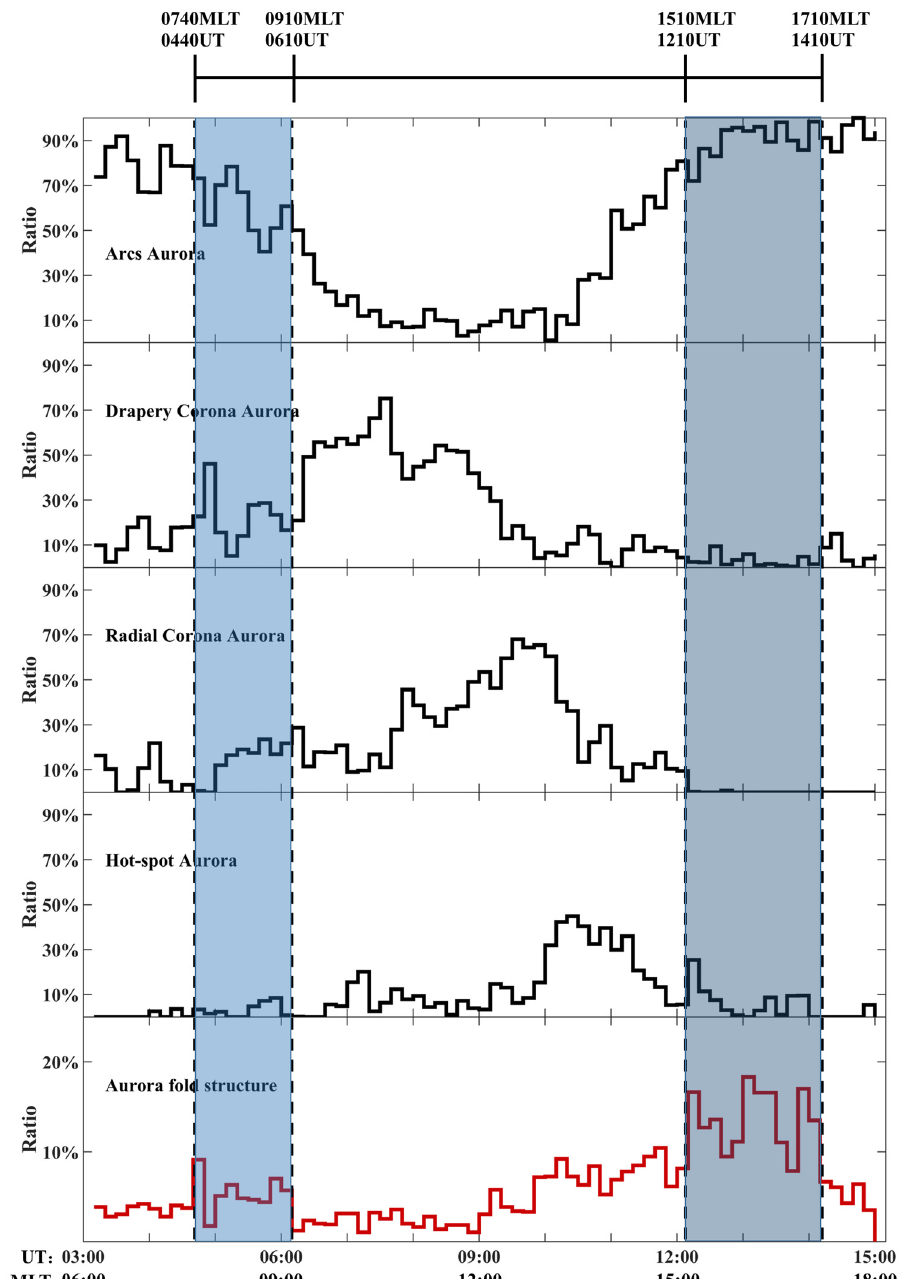
Figure 10. Temporal occurrence distribution of the aurora fold structure (bottom panel), which is compared with four categories of dayside aurora (1st–4th panel) in the D-dataset.